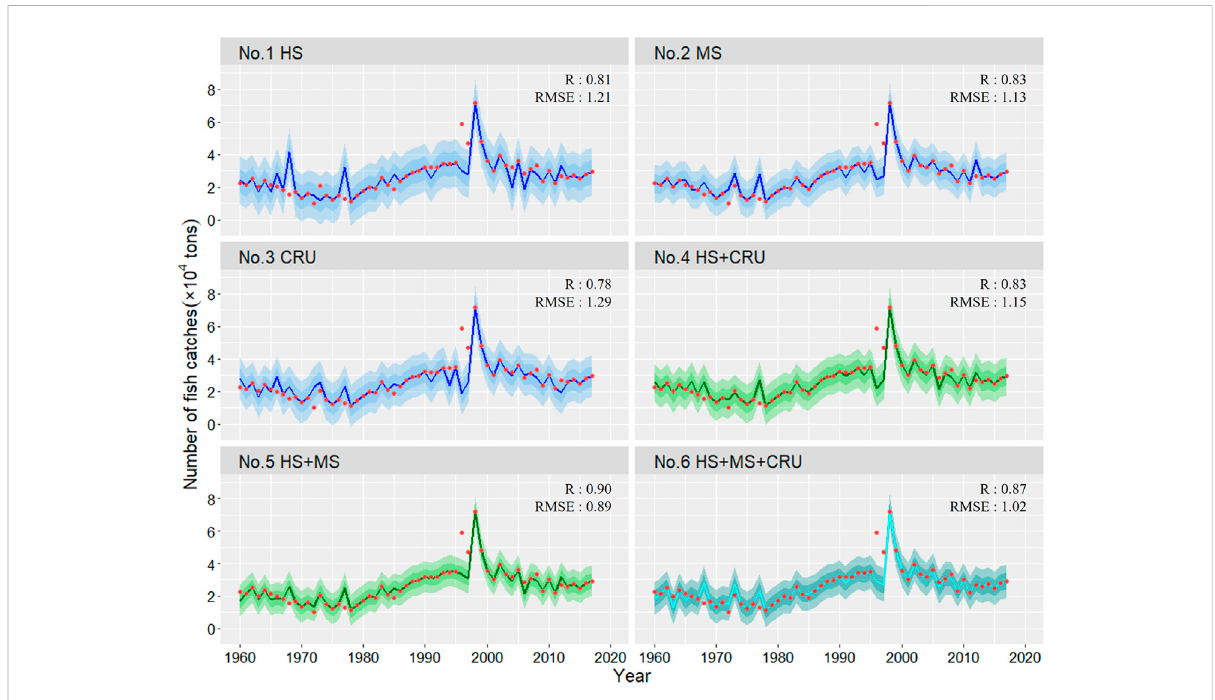
FIGURE 6 Long time series simulation results based on hydrometeorological variables. Red scatter represents the measured value of the fi sh catch. The solid line is the simulation result of fi sh catch. The dark ribbon is the one-fold SD of the simulation results, and the light ribbon is the two-fold SD of the simulation